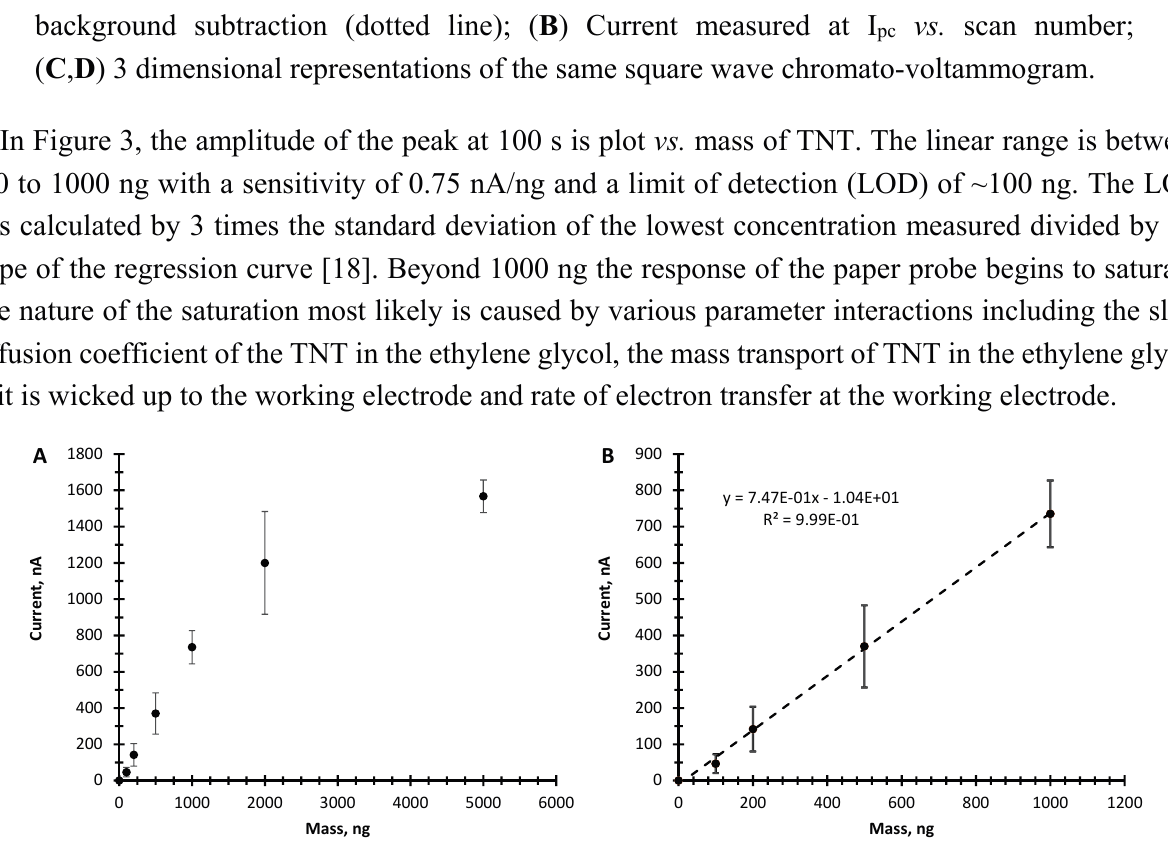
Figure 3. ( A ) Peak maximum in time vs. mass of TNT placed on the paper-probe from 100 to 5000 ng; ( B ) Current vs. mass of TNT in the linear range of 100 to 1000 ng.